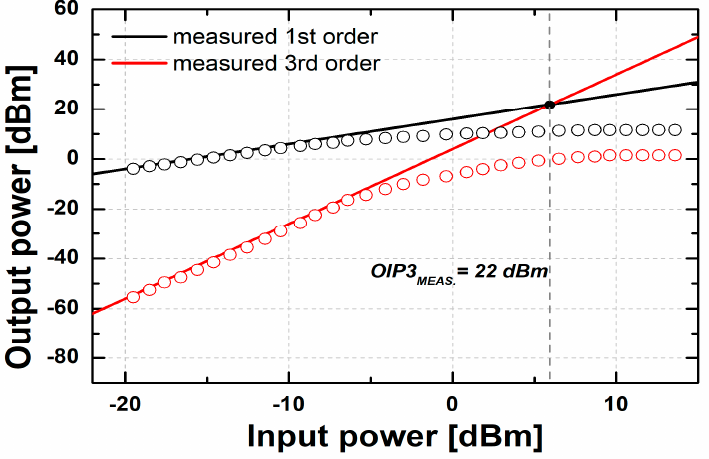
Figure 8. The output signal of the proposed PA, measured with the E4405B spectrum analyzer.